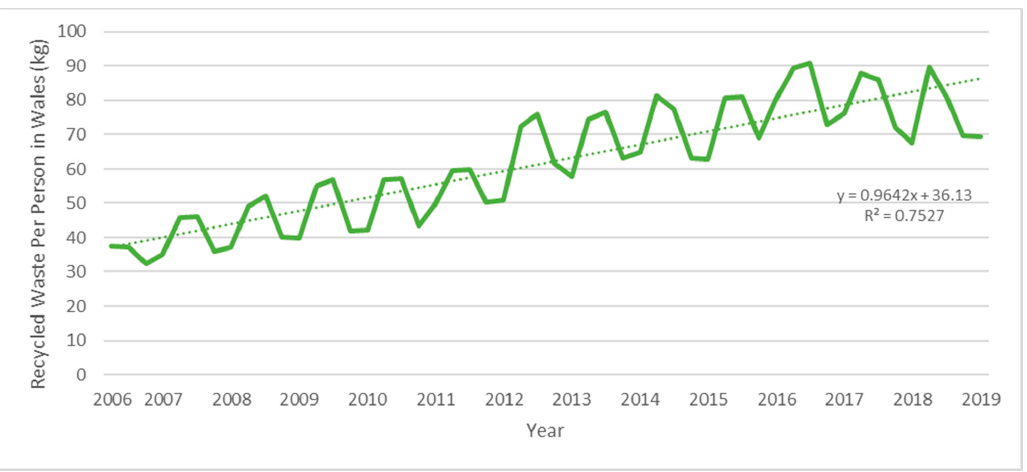
Figure 2. Total recycled waste per person (kg) per quarter; Welsh qverage. Source: WasteDataFlow and StatsWales. Dotted line shows trend line represented also in figure by regression equation and coefficient of determination (R 2 ).